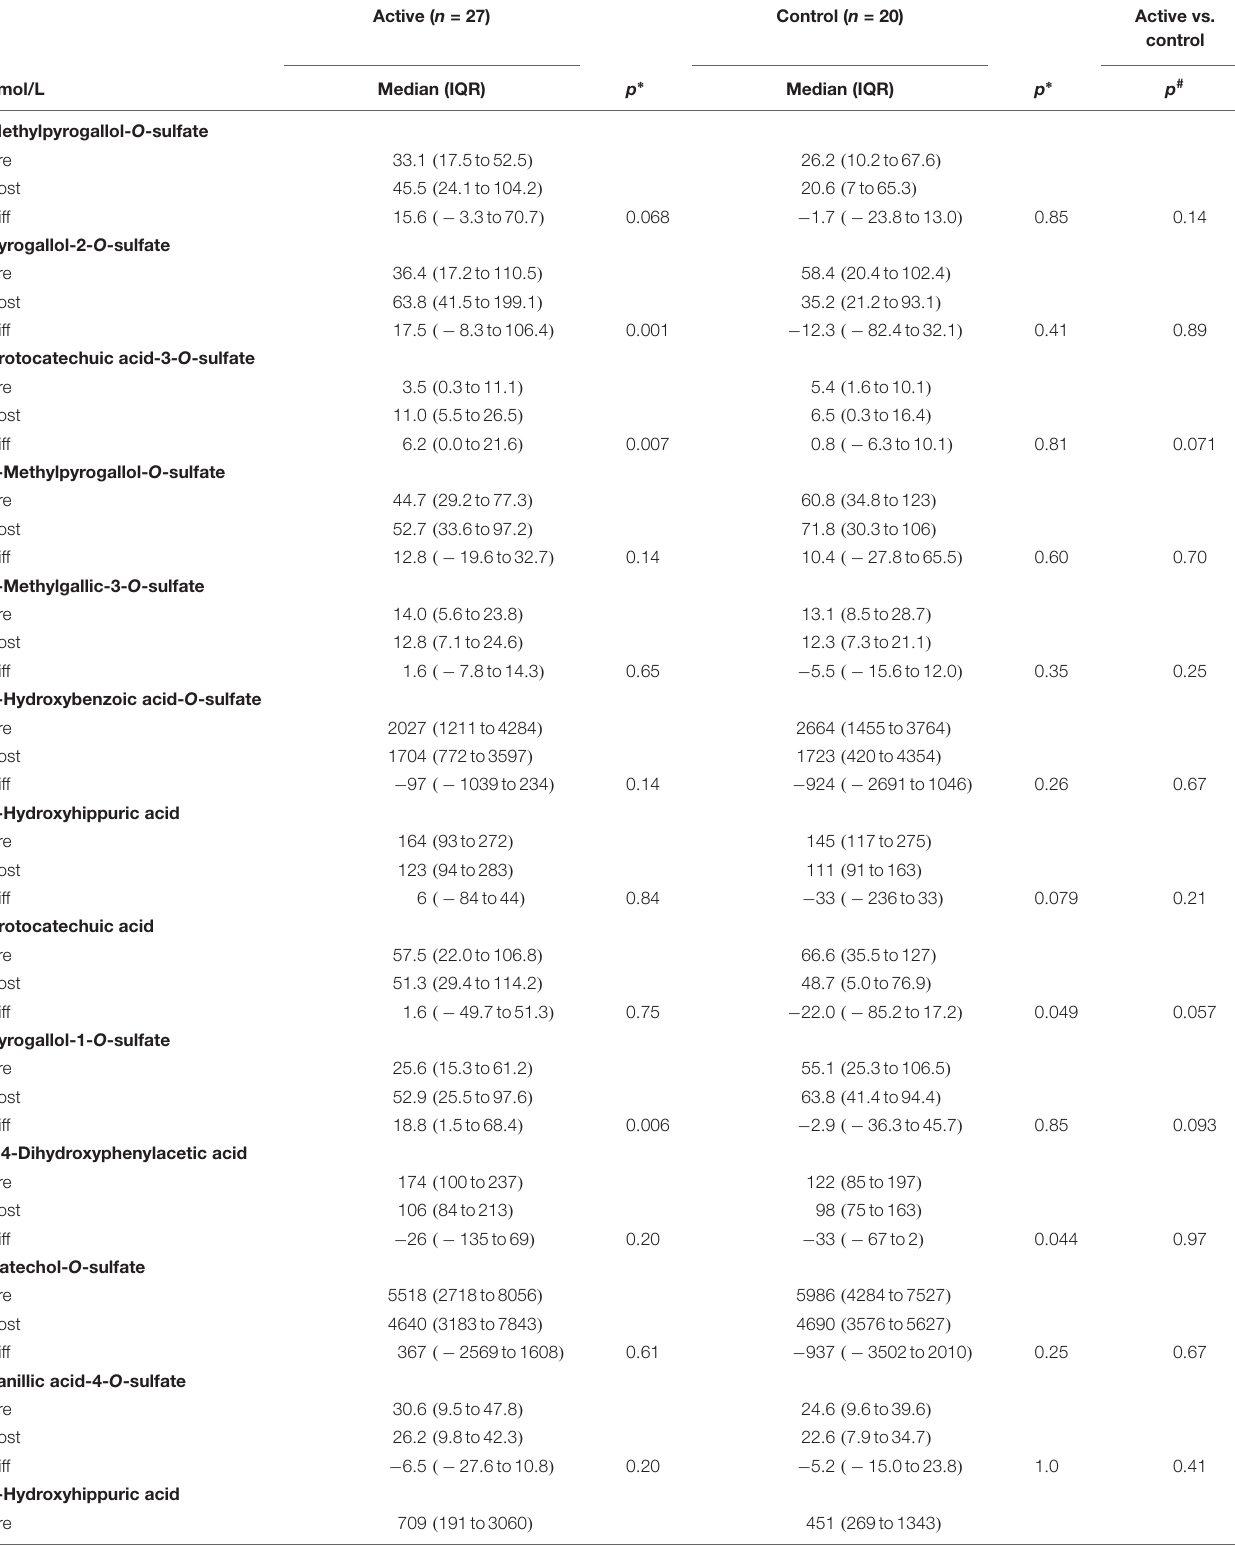
TABLE 3 | Changes from baseline to 16 weeks follow-up in plasma anthocyanin metabolites, for participants with supplementation (active) and for control participants. Active ( n = 27) Control ( n = 20) Active vs.